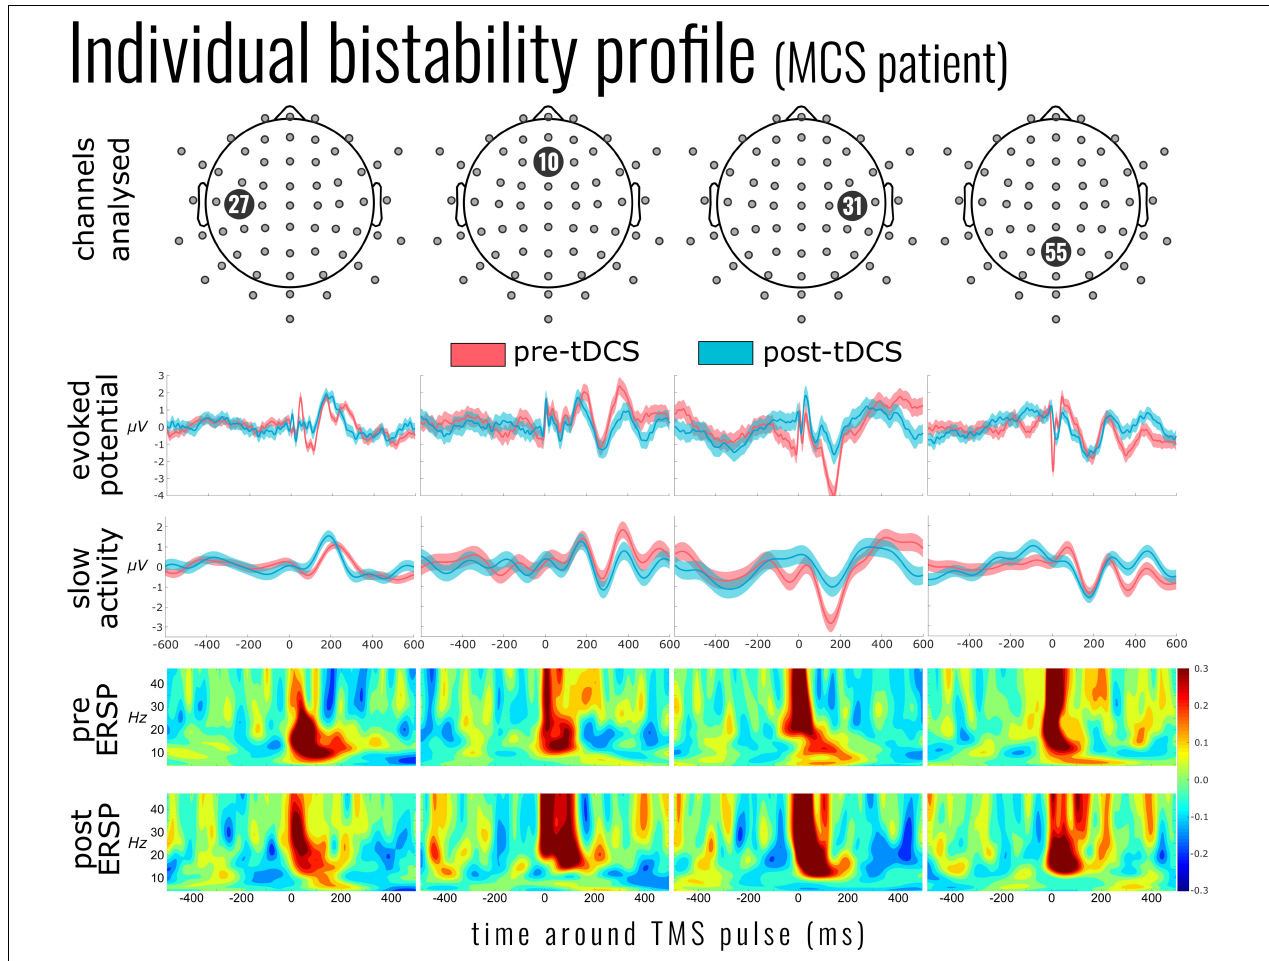
FIGURE 1 | Individual bistability profile of a patient in minimally conscious state (MCS; patient 6). Top panel indicates the exemplar channels 27, 10 [channel in the center of the supposed effect area of the transcranial direct current stimulation (tDCS)], 31 [nearest channel to the transcranial magnetic stimulation (TMS) pulse], and 55. The evoked potential panel shows the average electroencephalography (EEG) activity 600 ms before and after the single TMS pulses (mean of 267 pulses pre-tDCS and 220 post-tDCS). Below this is the mean slow activity, a low-pass-filtered signal of the TMS-evoked potential. The slow activity profile of channel 31 ( third column ) shows the reduction of slow activity after tDCS. The two panels below show the event-related spectral perturbation before and after tDCS intervention. Yellow to red indicates an increase in the power of the corresponding frequency (compared to the mean baseline activity), while shades of blue indicate a suppression of those